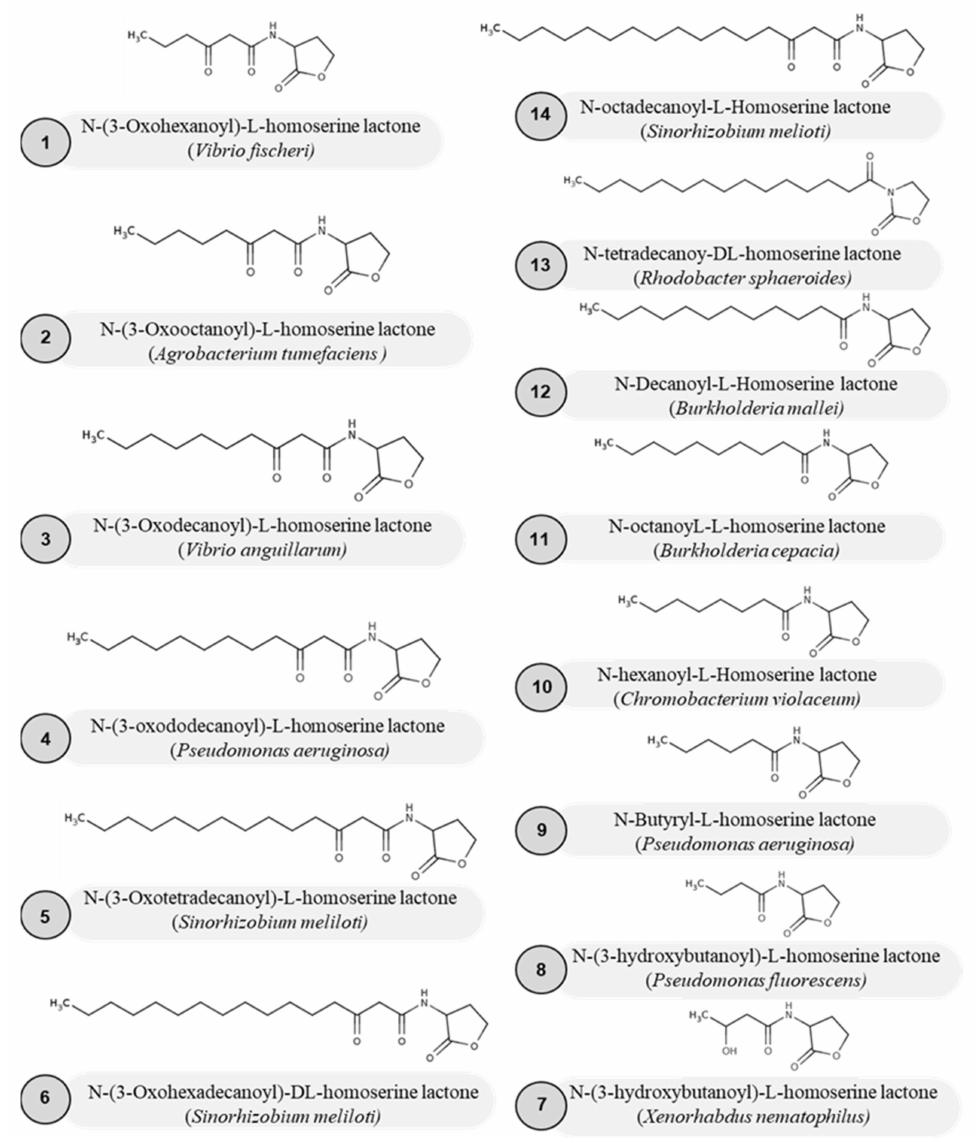
Figure 2. Structural diversity in AHL signals in bacteria. Chemical structure of various AHLs produced by bacteria: 3-oxo-C6-HSL1 ( 1 ), 3-oxo-C8-HS ( 2 ), 3-oxo-C10-HSL ( 3 ), 3-oxo-C12-HSL ( 4 ), 3-oxo-C14-HSL ( 5 ), 3-oxo-C16-HSL ( 6 ), 3-hydroxy-C4-HSL ( 7 ), 3-hydroxy-C8-HSL ( 8 ), C4-HSL ( 9 ), C6-HSL ( 10 ), C8-HSL ( 11 ), C10-HSL ( 12 ), C14-HSL ( 13 ), and C16-HSL ( 14